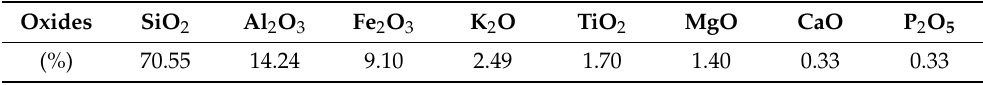
Table 2. Result of the semi-quantitative chemical analysis of the morisca sample by XRF.